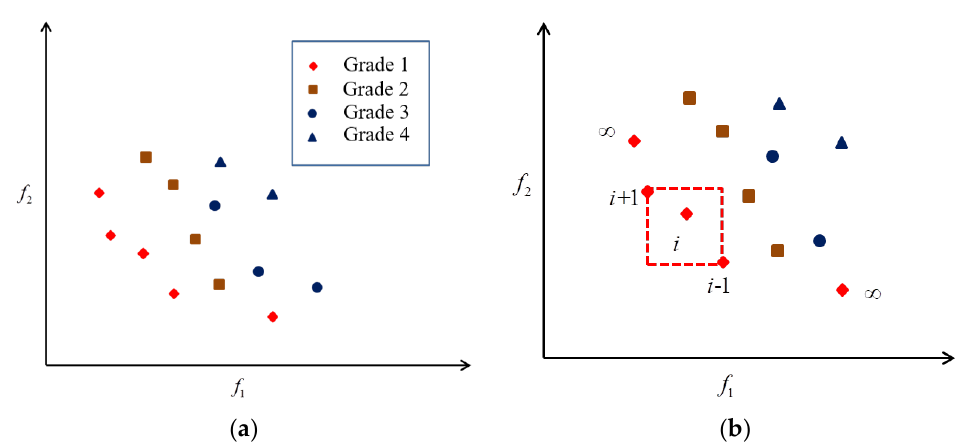
Figure 3. Non-dominated sorting and crowding distance: ( a ) non-dominated sorting; ( b ) crowding